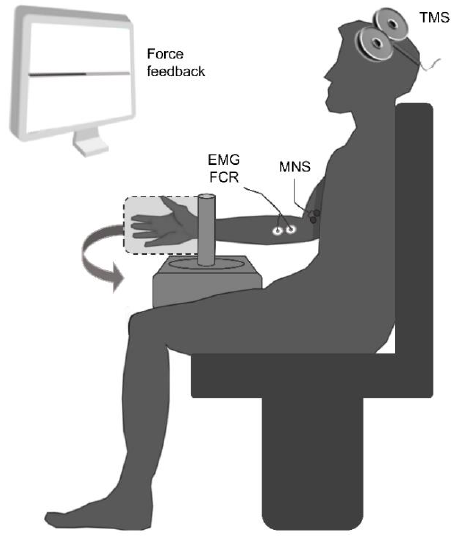
Figure 1. Schematic view of the experimental setup. Transcranial magnetic stimulation (TMS);